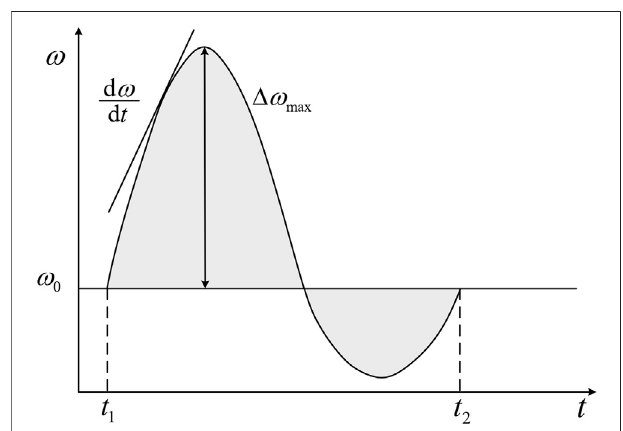
FIGURE 3 | Dynamic evaluation index of the rotor